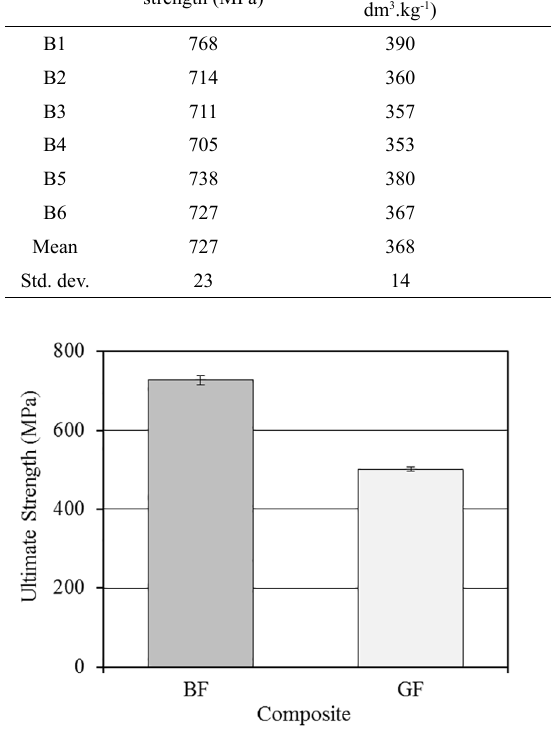
Table 1. Tensile strength and specific tensile strength of ring specimen BF and GF composites. Specimen